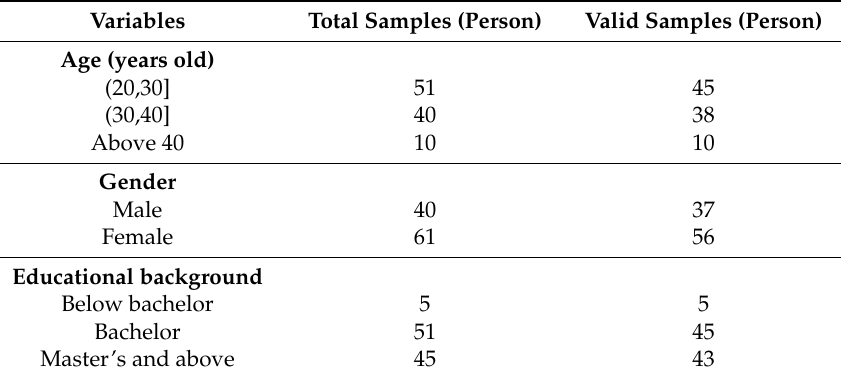
Table 1. Description of subjects for experimental